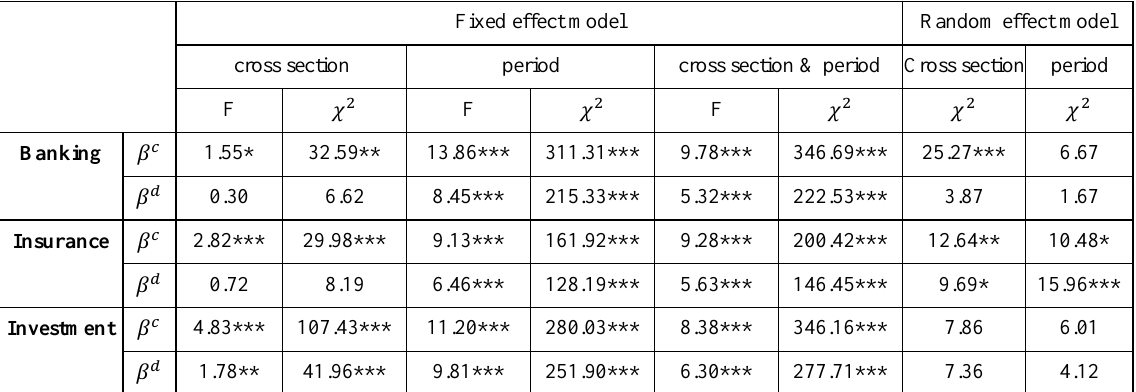
Table 4: Hausman test and fixed effect model test